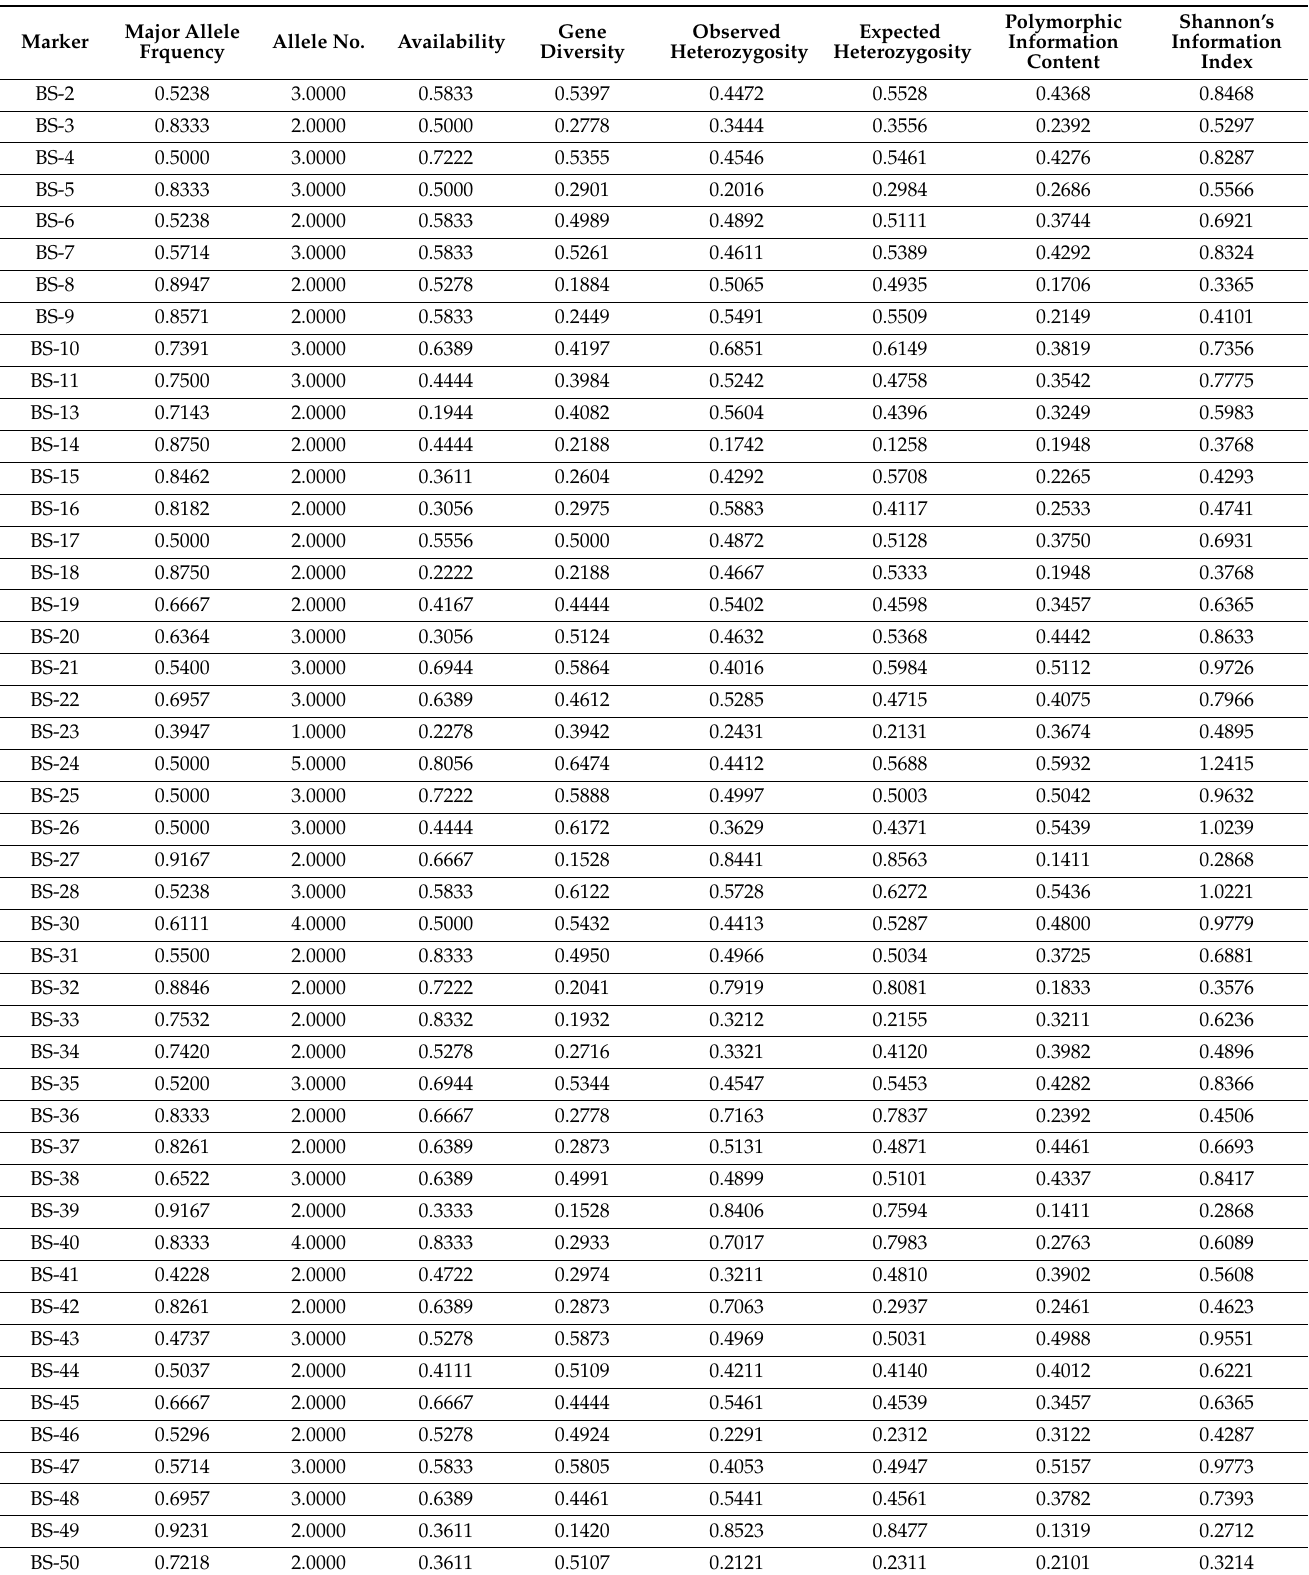
Table 2. Polymorphism analysis and diversity indices of the microsatellite loci used in the